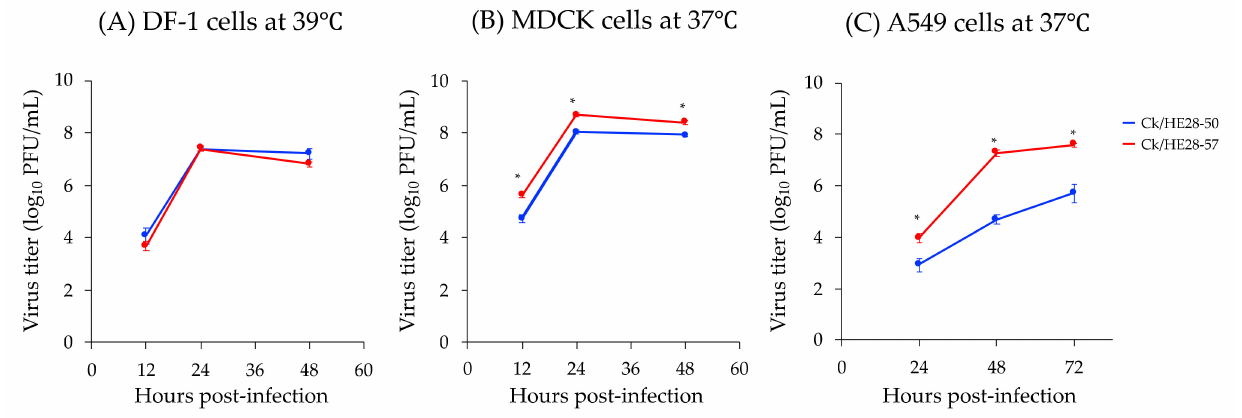
Figure 1. Replicative ability of two H9N2 viruses in DF-1, MDCK, and A549 cells. DF-1 ( A ), MDCK ( B ), and A549 ( C ) cells were infected with Ck/HE28-50 or Ck/HE28-57 at a multiplicity of infection of 0.001 and incubated at the indicated temperatures. Virus titers are presented as the mean ± standard deviation (SD) of two independent experiments. * indicates p < 0.05 Ck/HE28-50 versus